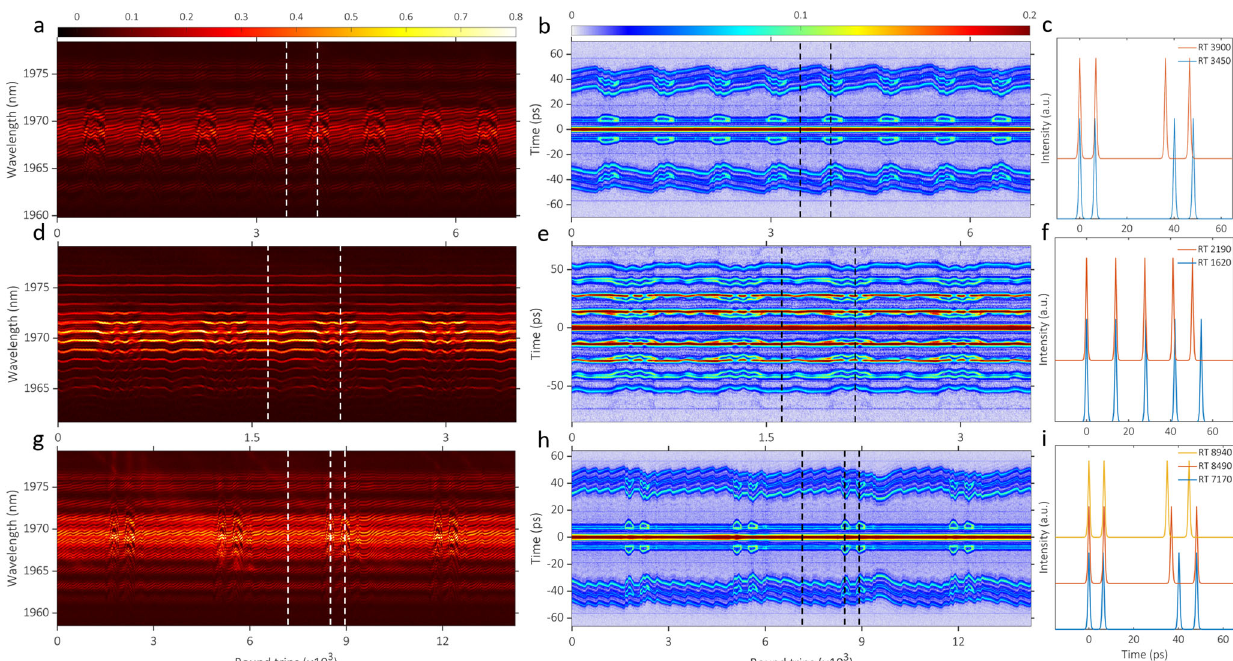
Fig. 5 Consecutive switching of oscillating soliton molecular complexes with periodic pump power modulation. a – c Consecutive switching of (2 + 2) OSMC with a modulation frequency of 20 kHz. d – f Consecutive switching of oscillating soliton quintet molecule with a modulation frequency of 20 kHz. g – i Consecutive switching of (2 + 2) OSMC with a modulation frequency of 5 kHz. a , d , g The real-time spectral evolution measured via DFT. b , e , h The corresponding fi eld autocorrelation traces. c , f , i The temporal pulse distribution of several typical RTs corresponding to the black dashed lines in ( b , e , h ),